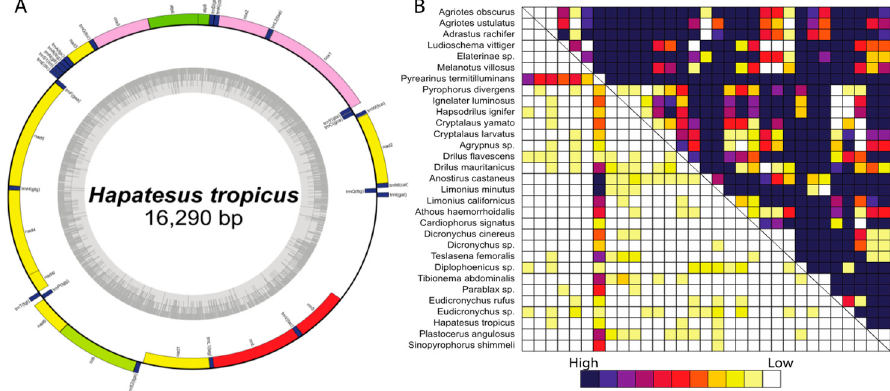
Figure 2. ( A ) A scheme of the circular mitogenome of Hapatesus tropicus Neboiss, 1958; ( B ) rectangular heat map calculated with SymTest showing p -values for the pairwise Bowker’s tests in the datasets C (amino acids, lower triangle) and A (nucleotides, upper triangle). Darker boxes indicate lower p -values and thus larger deviation from evolution under stationarity, reversibility, and homogeneity (SRH) conditions.